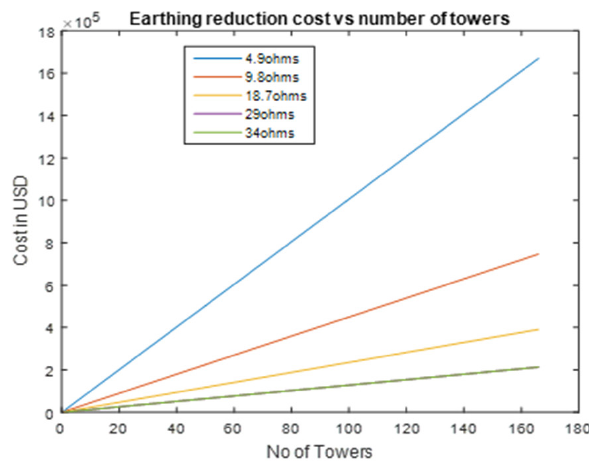
Figure 9. Cost of earthing reduction for 166 towers.